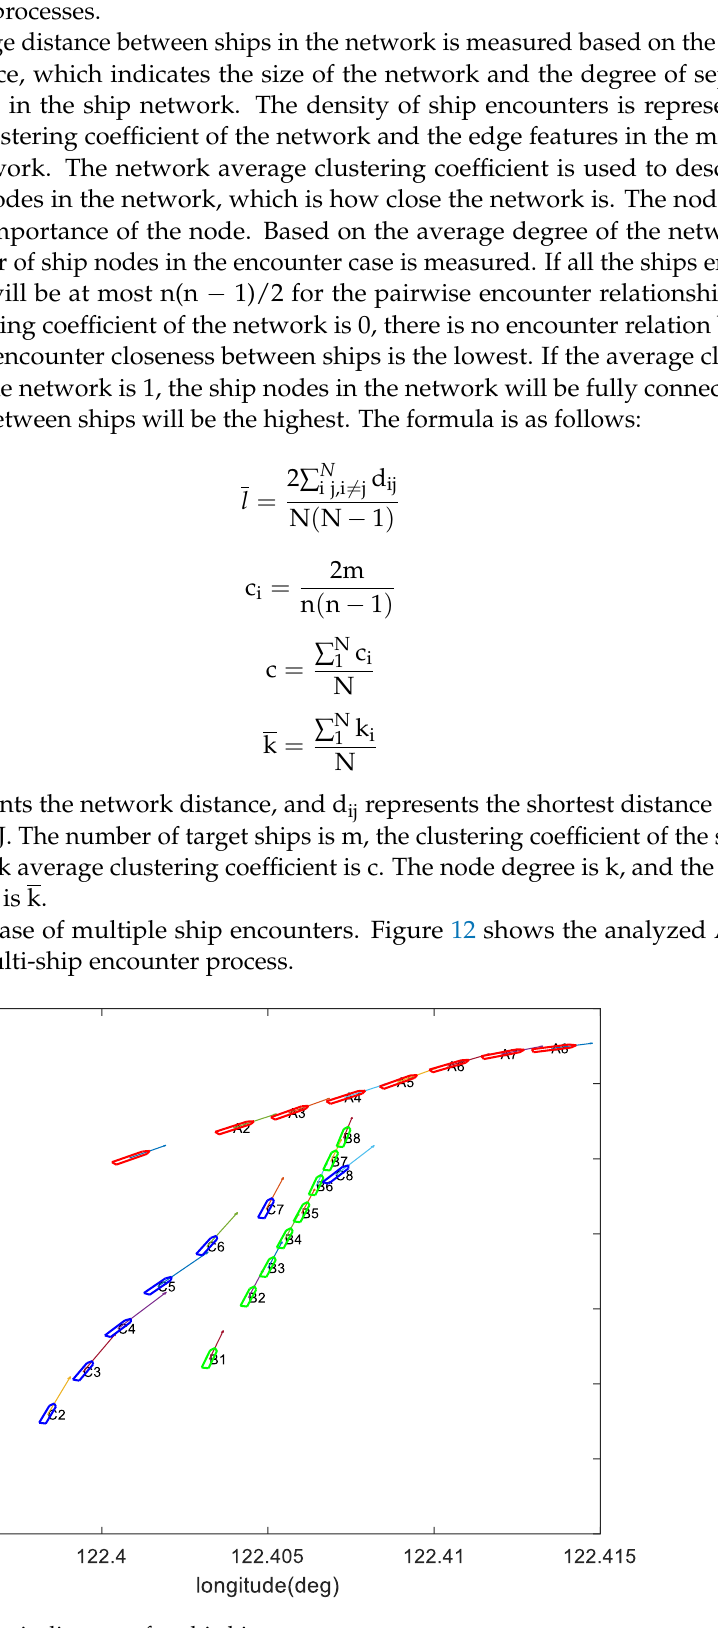
Figure 13. Multi-ship encounter process analysis. The essence of a ship encounter is that the distance decreases first and then increases, and the situation of a ship encounter changes from simple to complex and then to simple. It can be seen from the line diagram that in the process of ship encounter, the network